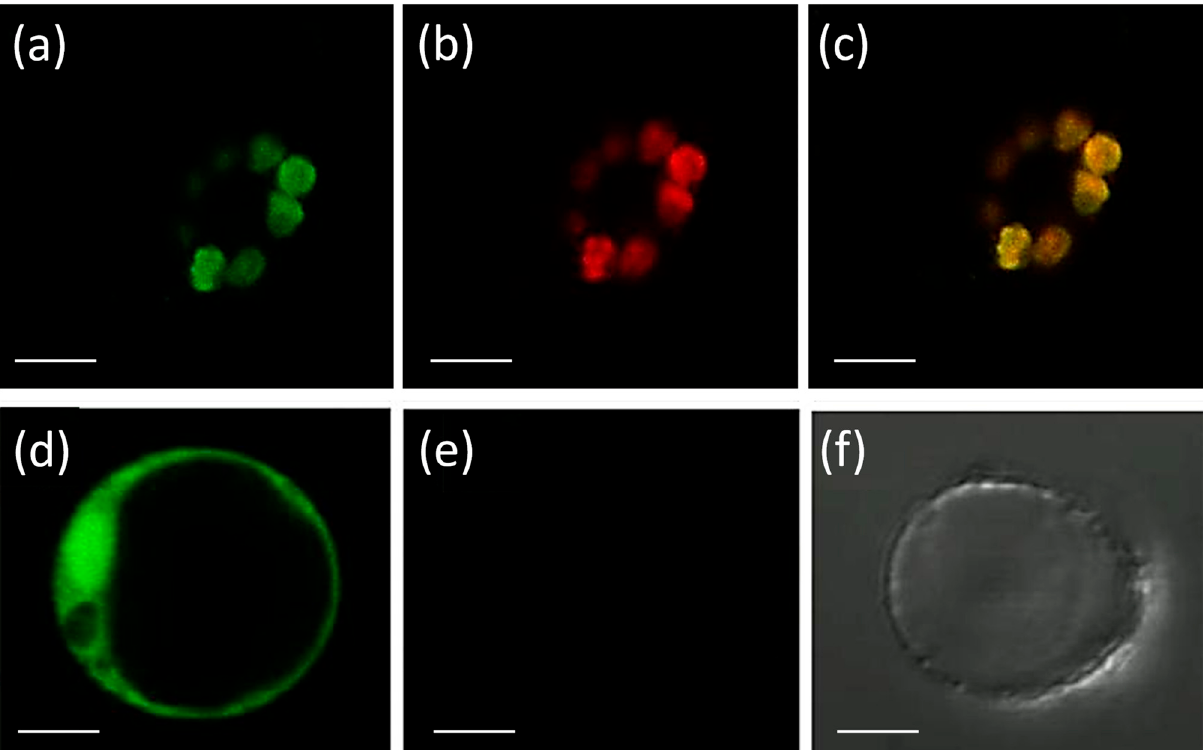
Figure 1. Subcellular localization of OsAPX7 protein in rice protoplasts. Subcellular localization of the OsAPX7 protein in chloroplasts in rice protoplasts through transient expression of the 35S- OsAPX7::YFP cassette. ( a ) green signals indicate YFP fluorescence; ( b ) red signals indicate chlorophyll autofluorescence, and ( c ) yellow signals are the merged image; ( d ) positive control of the localization, using 35S::YFP cassette; ( e , f ) negative control, using protoplast without 35S::YFP cassette. All scale bars represent 10 µm.